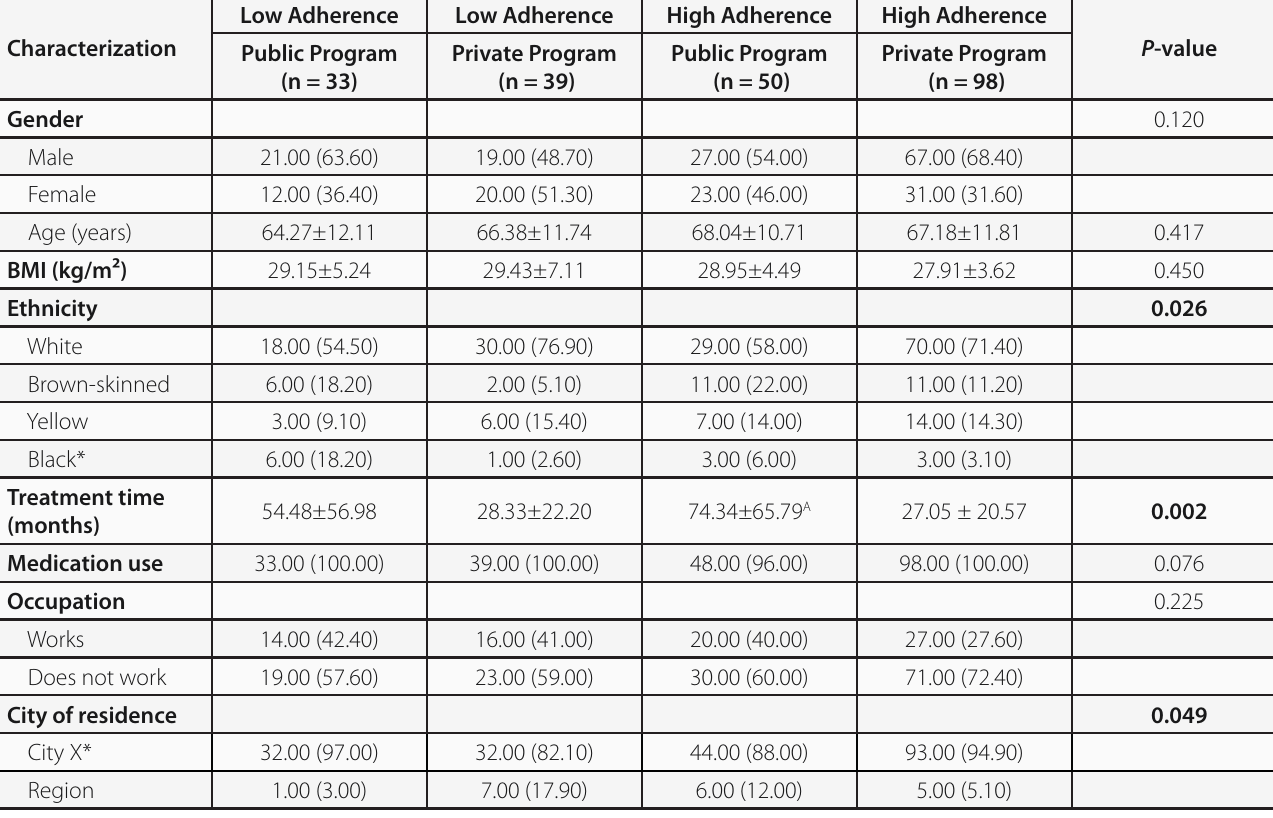
Table 1. Characterization of patients concerning gender, age, BMI, ethnicity, treatment time, medication use, occupation, and city of residence according to the type of program and